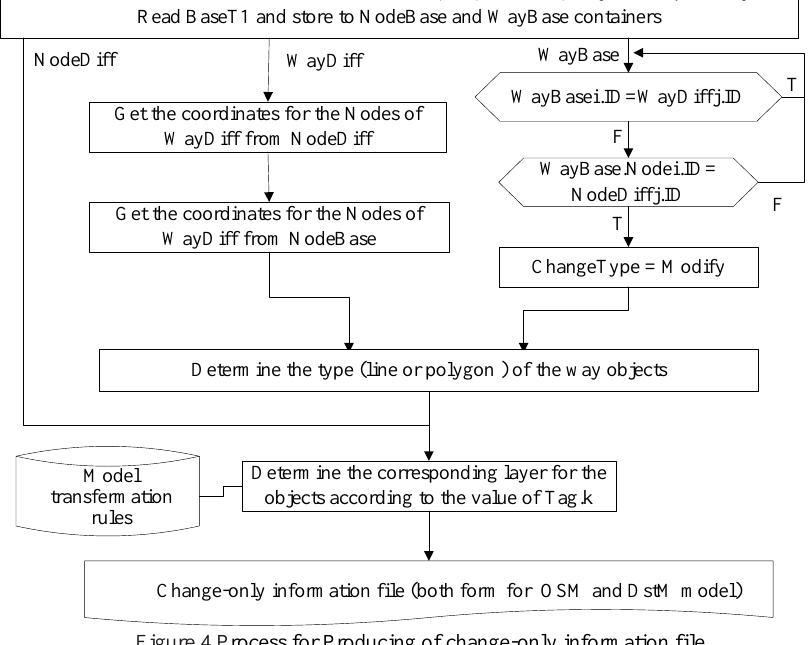
Figure 4 Process for Producing of change-only information